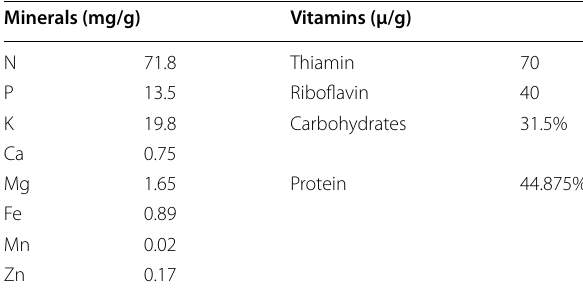
Table 5 Chemical analysis of active dry